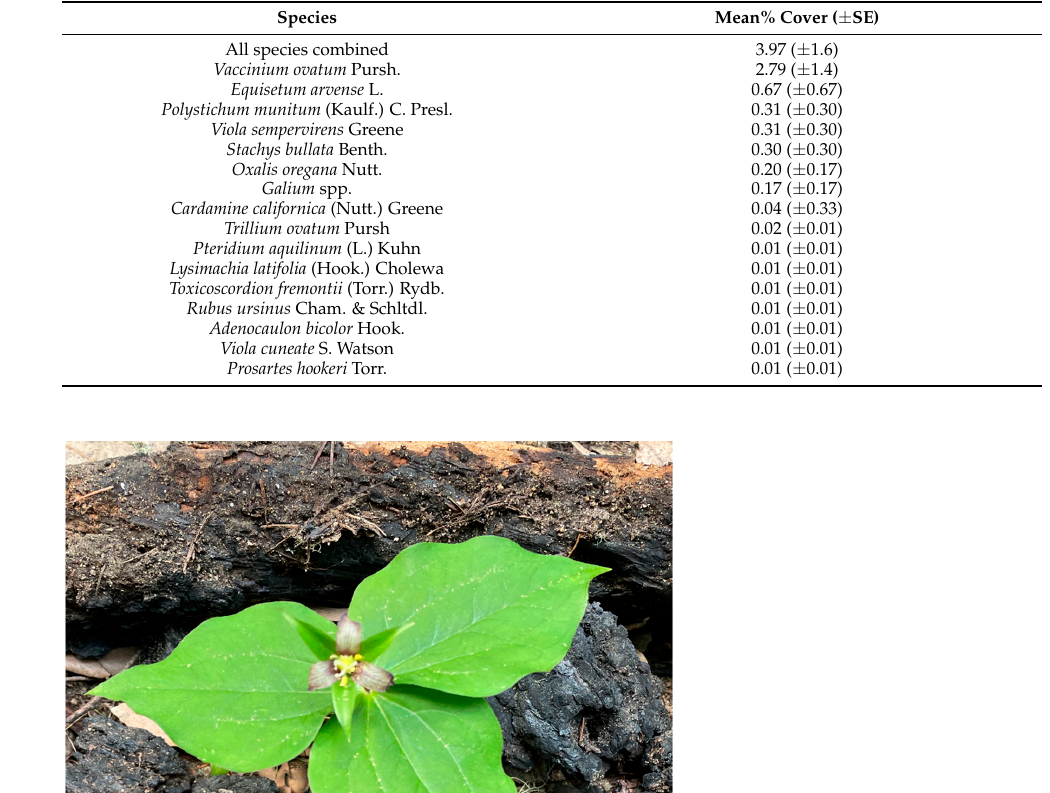
Table 1. Percent cover of sixteen recovering understory species recorded following a high severity wildfire in Big Basin Redwood State Park in the Santa Cruz Mountains, California.